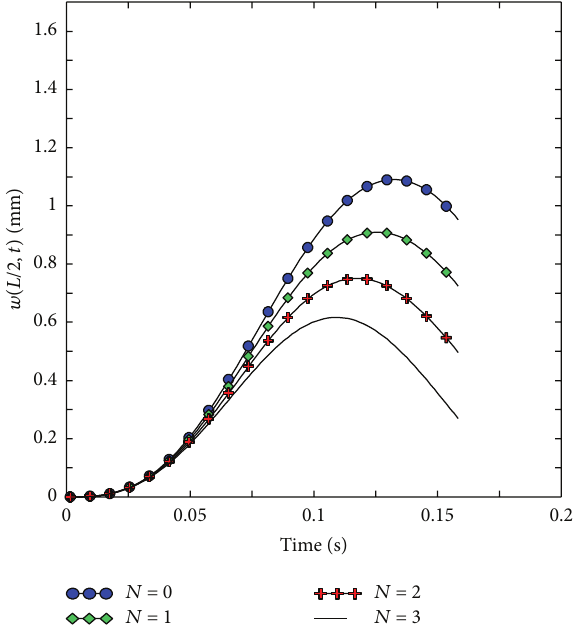
Figure 12: The dynamic response ( 𝑤(𝐿/2,𝑡) ) for the beam with 𝜁 = 0.075 ,subjectedtoamovingvehicleandattachedtomanyabsorbers.